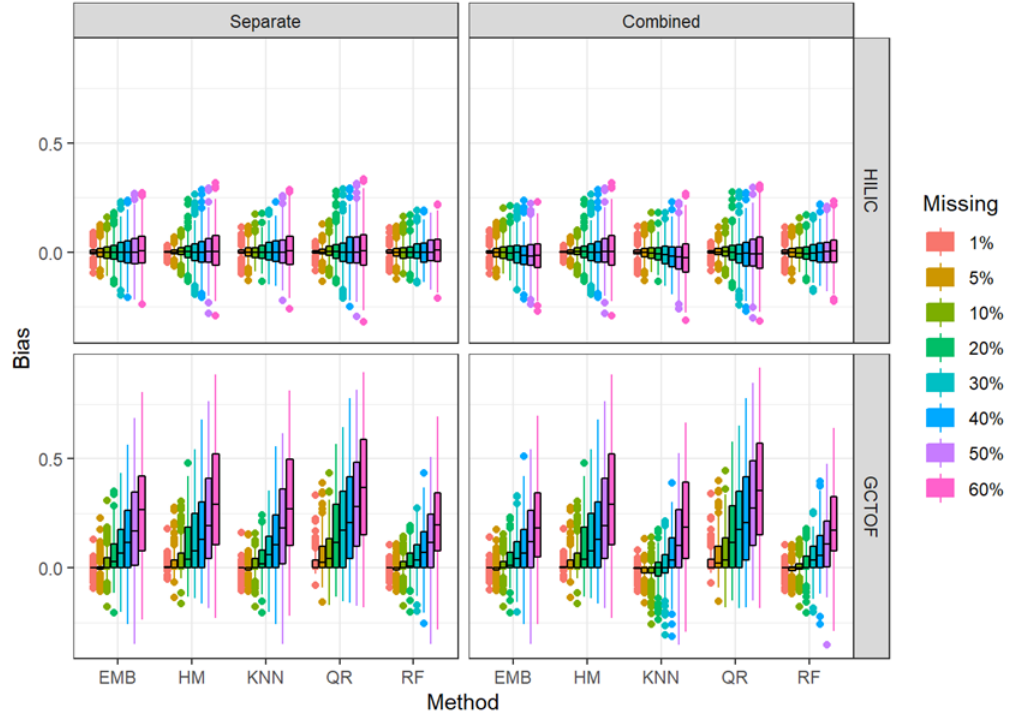
Figure 3. Box and whisker plots of bias in the estimated between-biospecimen correlations from imputed data for HILIC and GCTOF data sets for the separate and combined